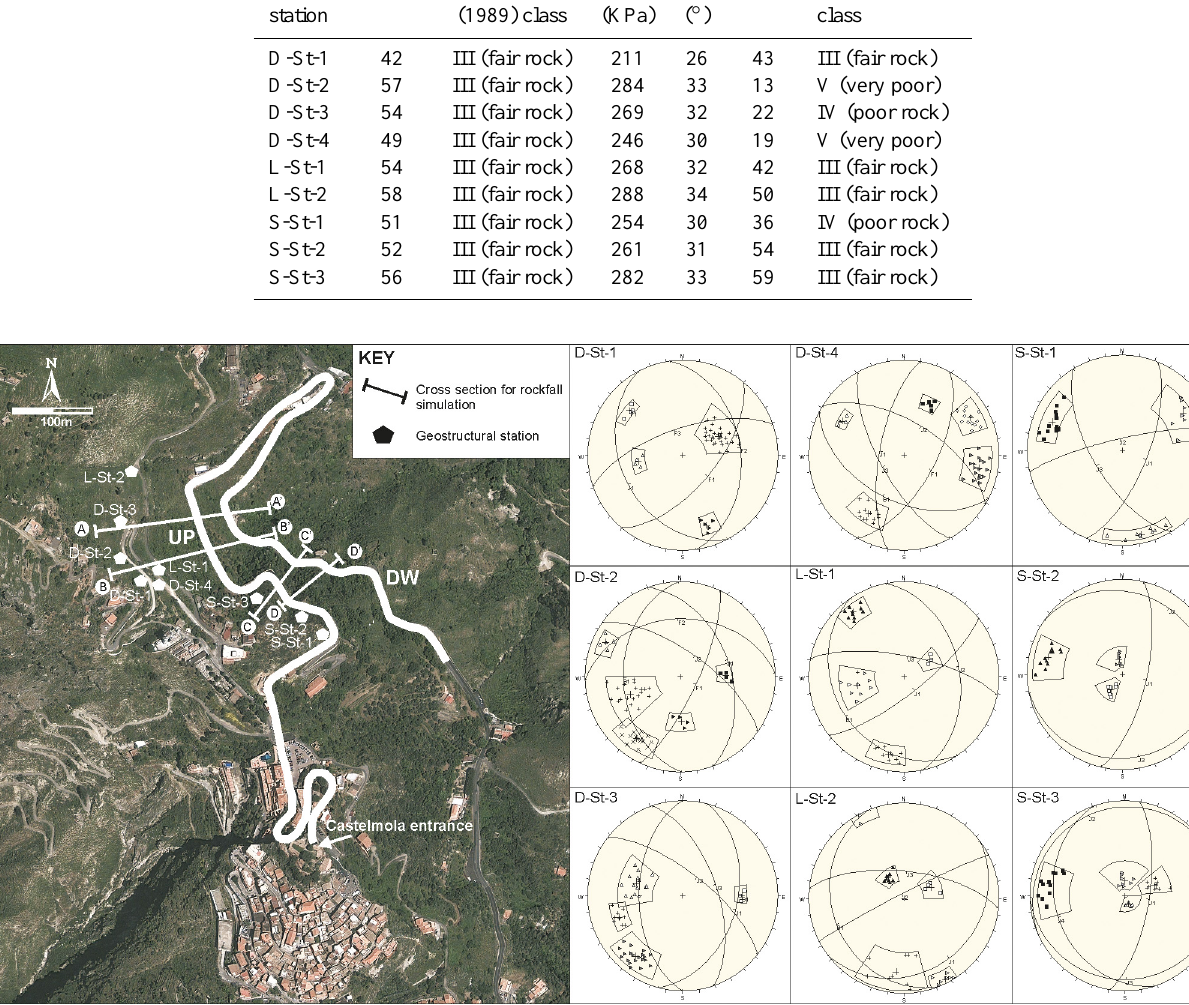
motion. The analysis considers the combined effects of free falling, bouncing, rolling and sliding; the block impact is in- fluenced by the slope roughness and the block size (Giani,